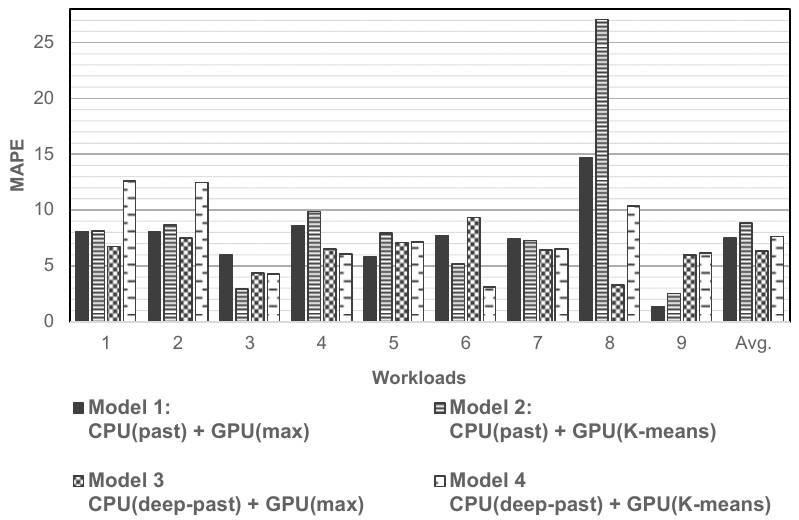
Figure 9. Test results of four power models built with combinations of proposed methods.